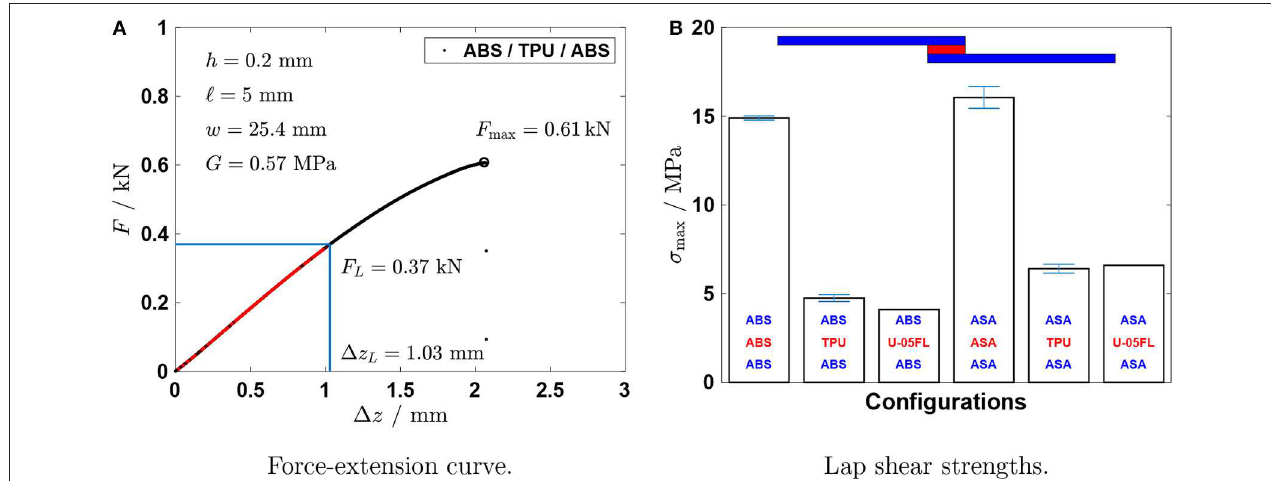
FIGURE 2 | Experimental lap shear results. (A) Load F vs. extension 1 z . The maximum point represents the maximum force that is required to disbond the lap shear. The red highlighted section of the data (cid:0) 1 z L ∈ [ 0,1.03 ] ,mm (cid:1) represents the linear region of the force-extension curve. An associated shear modulus G is also provided. (B) Adhesive strength for configurations. Adhesive strength of Loctite ® U-05FL TM Hysol ® is given for comparison 1 . Error bars represent standard deviation over multiple trials ( n = 4). Lap shear designs are indicated in the graph by the upper substrate (blue), the joint (red), and the lower substrate (blue).